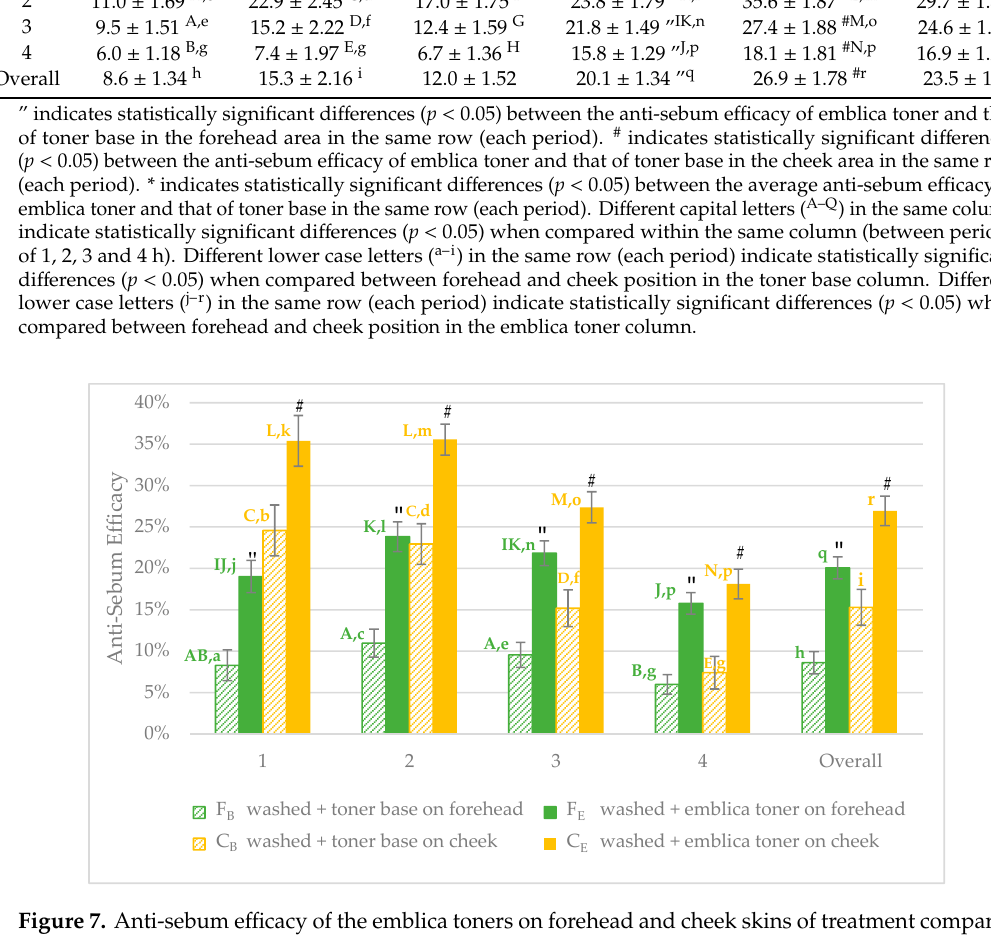
” indicates statistically significant differences ( p < 0.05) between the anti-sebum efficacy of emblica toner and that of toner base in the forehead area in the same row (each period). # indicates statistically significant differences ( p < 0.05) between the anti-sebum efficacy of emblica toner and that of toner base